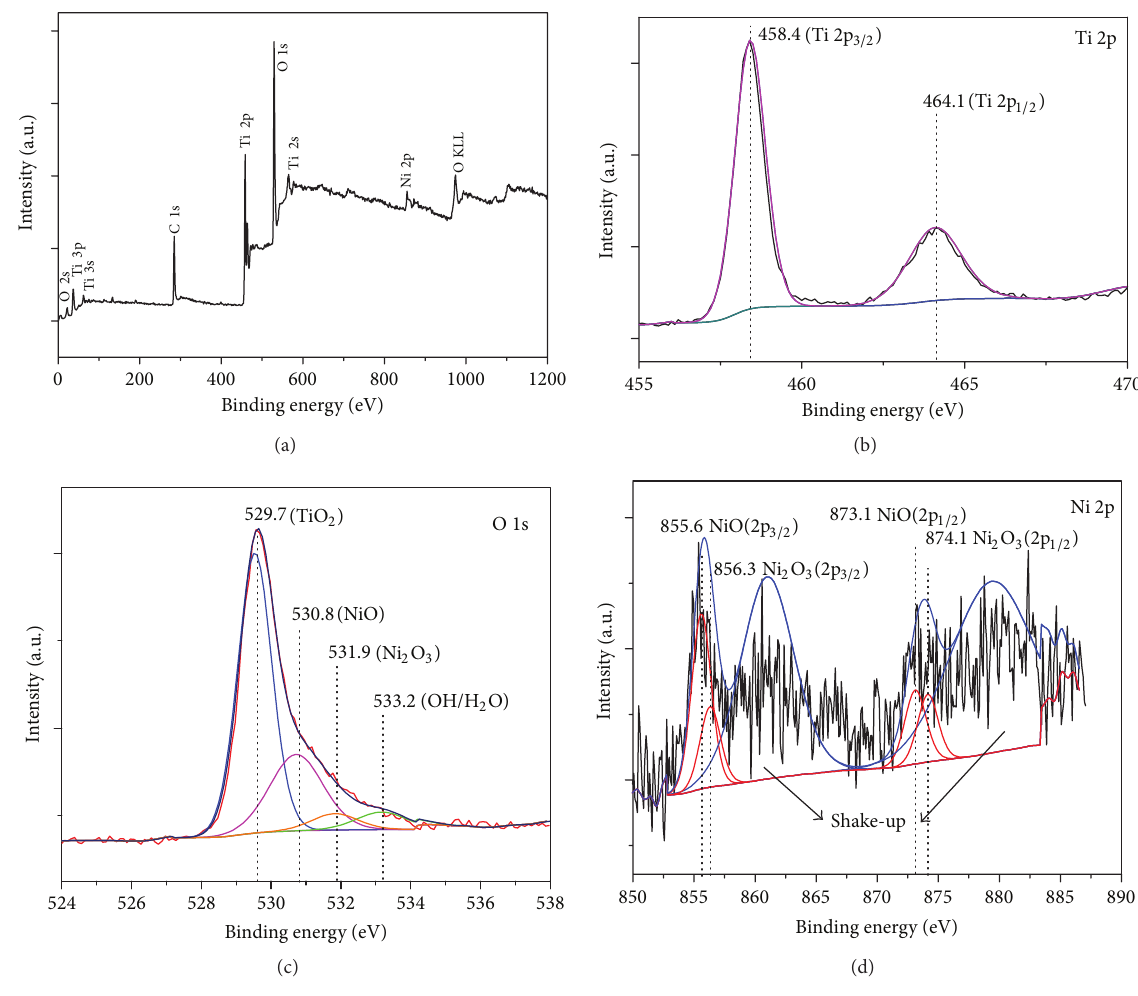
Figure 6: XPS spectra of NiO/TNTs (0.5M) (a) fully scanned spectra, (b) Ti 2p peak, (c) O 1s peak, and (d) Ni 2p